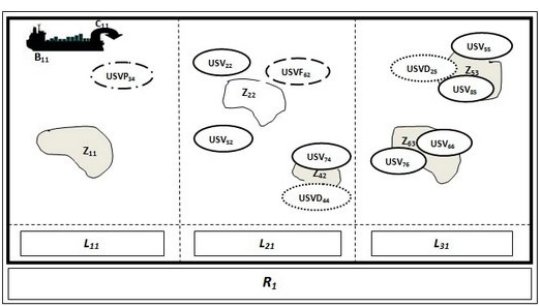
Figure 14: SUSV-C planning domain combined with USVS-C planning domain.